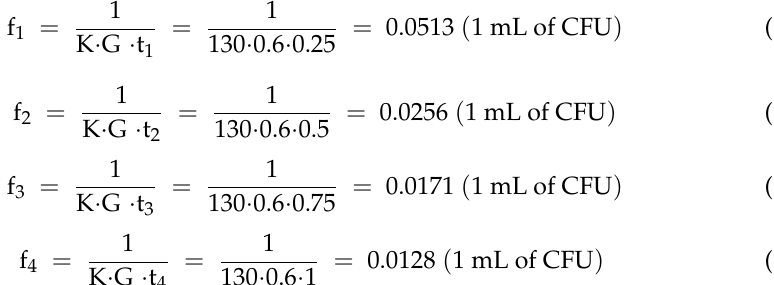
Figure 9. Interaction of water composition with microbiological indicators and ozone time.